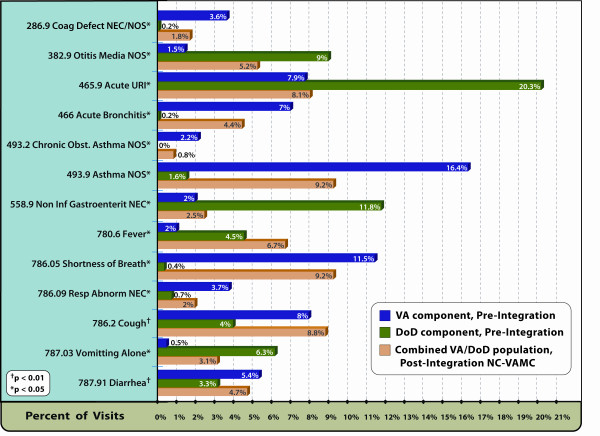
Most frequently utilized ICD-9 diagnosis codes. Display of the most frequently recorded ICD-9 diagnosis codes for the ESSENCE Biosurveillance syndrome categories, North Chicago VAMC/Lovell FHCC, Pre- and Post-Integration.